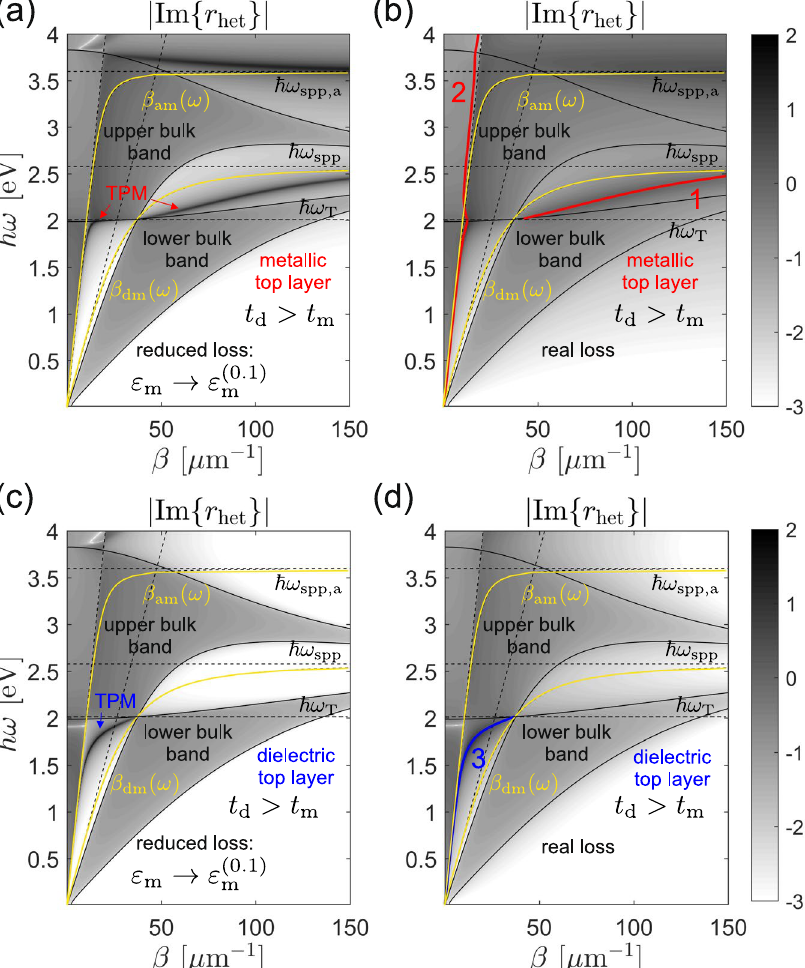
Figure 7. Maps of |Im{ r het }| drawn in logarithmic scale with the colormap chosen so that all values outside the ( − 3, 2) interval are saturated. Top panels are drawn for superlattices terminated by a metallic layer ( ε 1 = ε m ), while the bottom ones correspond to a dielectric top layer ( ε 1 = ε d ). Left panels: maps obtained by multiplying the imaginary part of the silver permittivity by p = 0.1 in order to sharpen the features and render TPMs visible. Right panels: maps obtained by taking the loss fully into account. All maps correspond to the t d > t m example. The two slanted dashed lines represent the ε a and ε d light